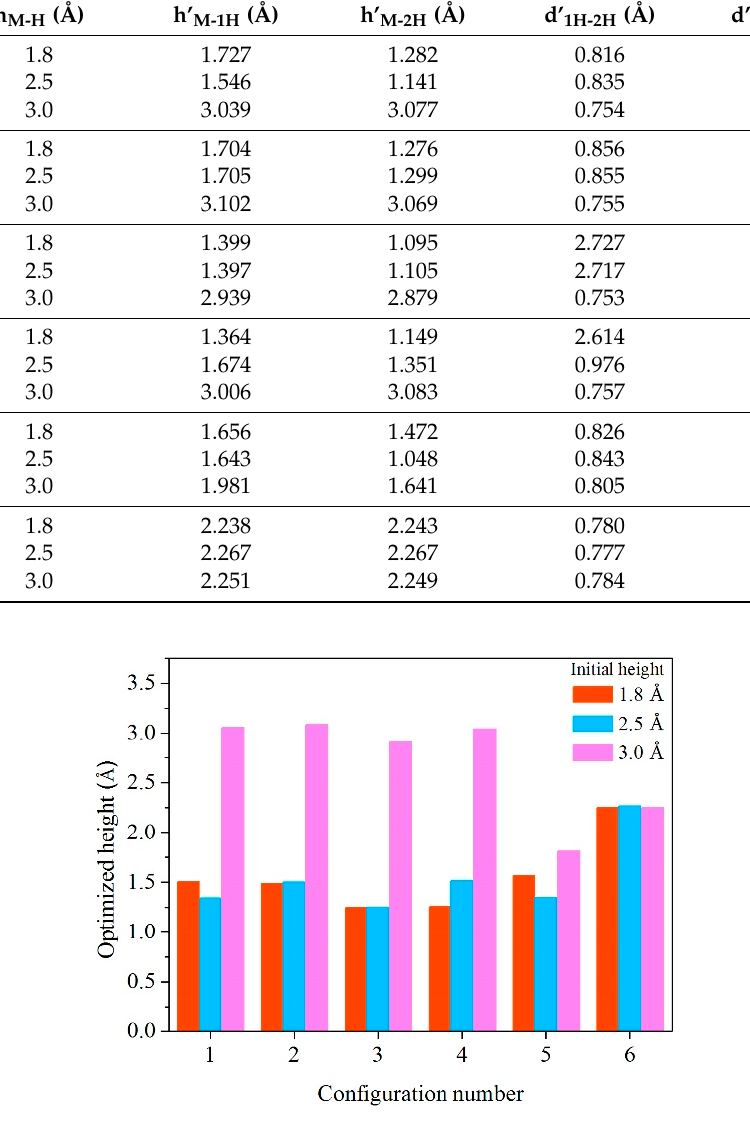
Figure 3. The average optimized height for the molecular hydrogen desorption on TiZrVMoNb hydride (110) surface in the six configurations with the initial heights of 1.8, 2.5 and 3.0 Å. The geometrical structures for the considered six configurations are shown in Figure 2.